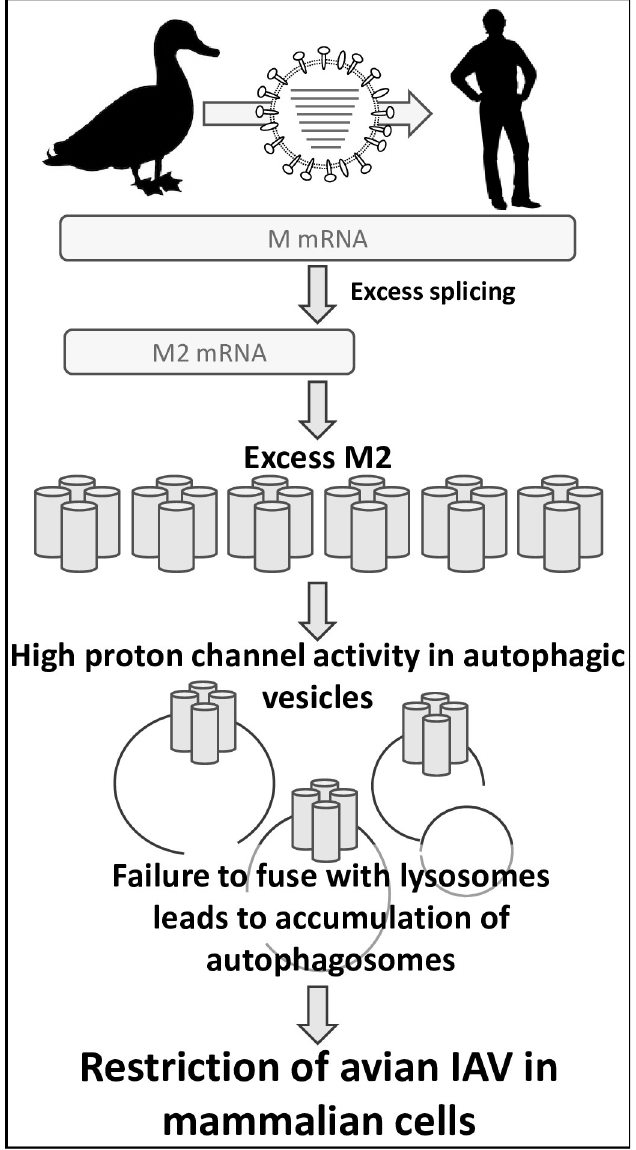
Fig 16. Regulation of M segment gene expression contributes to host range restriction of IAV. When an avian IAV M segment is transcribed within mammalian cells, excessive splicing of mRNA 7 results in aberrant overexpression of the M2 proton channel. When highly expressed, this channel accumulates in autophagic vesicles. Abundant proton channel activity in the membranes of autophagosomes blocks their turnover by preventing fusion with lysosomes. This stalling of a critical cellular housekeeping function in turn reduces the efficiency of viral replication, contributing to the species barrier that limits the zoonotic potential of avian IAVs.